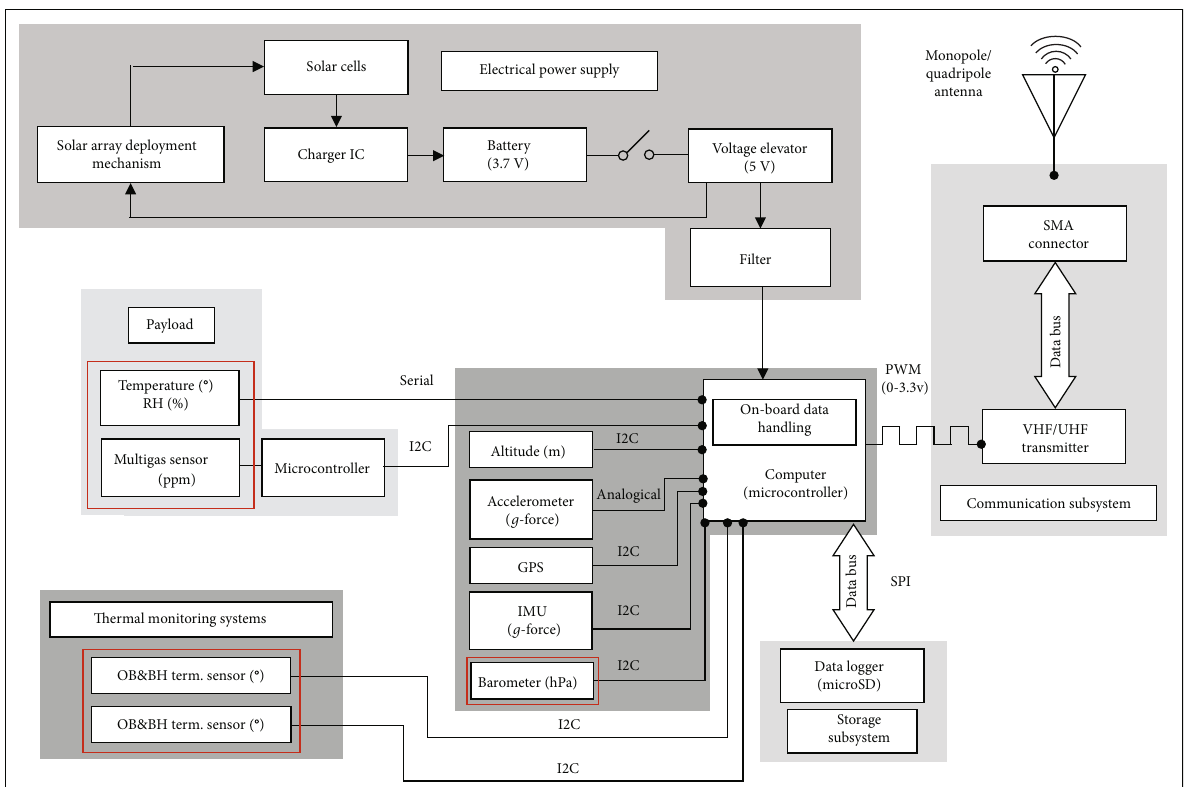
Figure 2: Block diagram of the subsystems of the Simple-2 module.